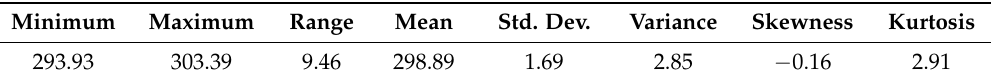
Table B5. Statistics of the dew-point temperature distribution [K].